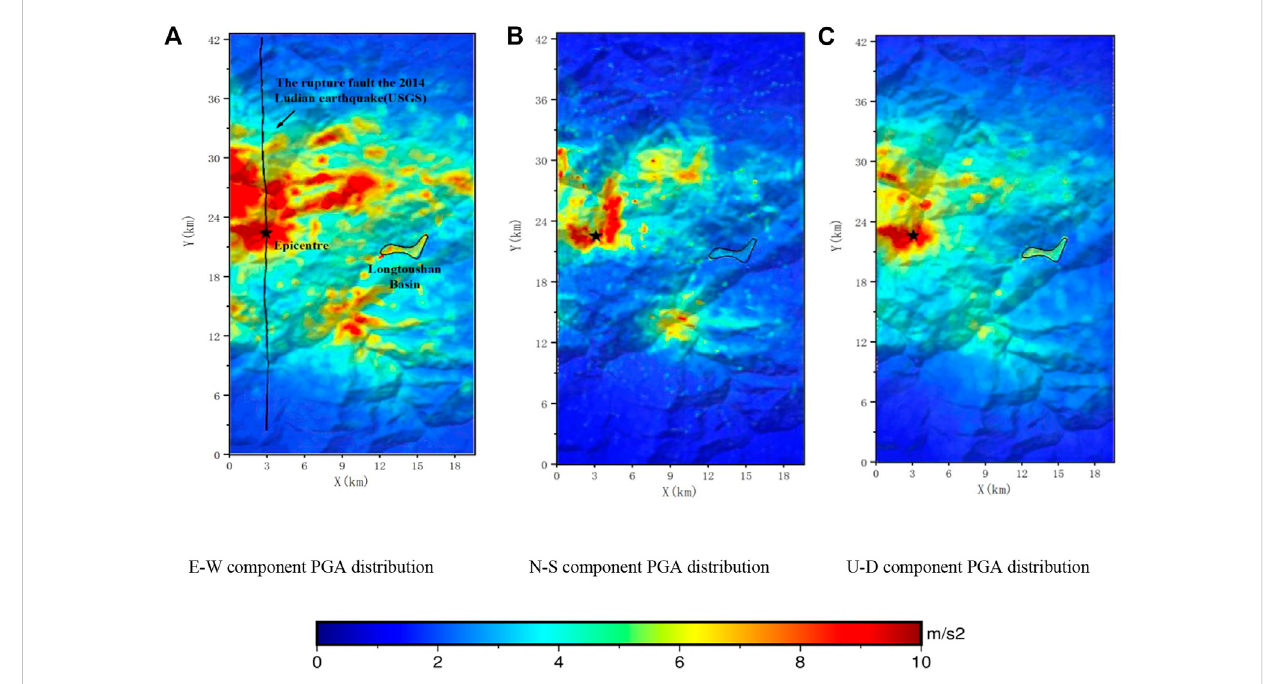
FIGURE 8 PGA distribution of the model. The black star and black line denote the epicenter and rupture fault of this earthquake provided by the USGS, respectively. (A) E-W component PGA distribution. (B) N-S component PGA distribution. (C) U-D component PGA distribution.